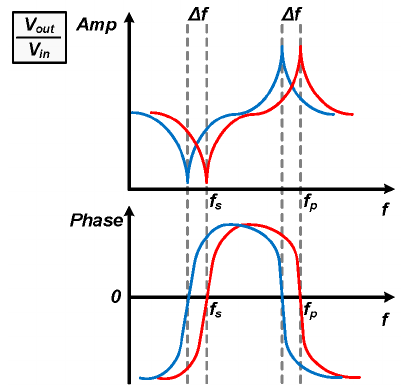
Figure 2. Frequency response of a driving amplifier when loaded by a one-port SAW device (upper part: amplitude-frequency response, lower part: phase-frequency response).